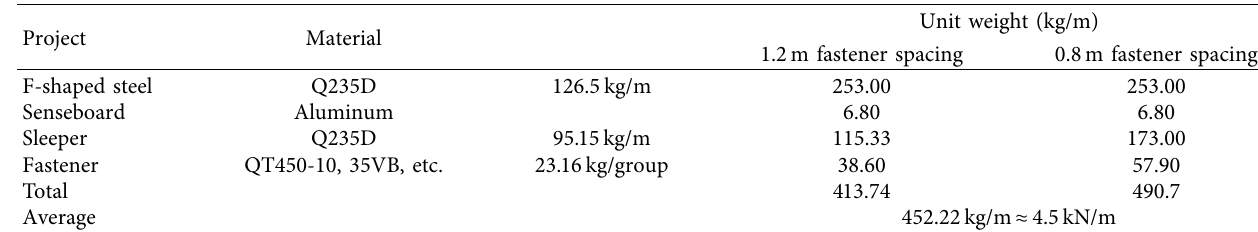
Table 2: Track load